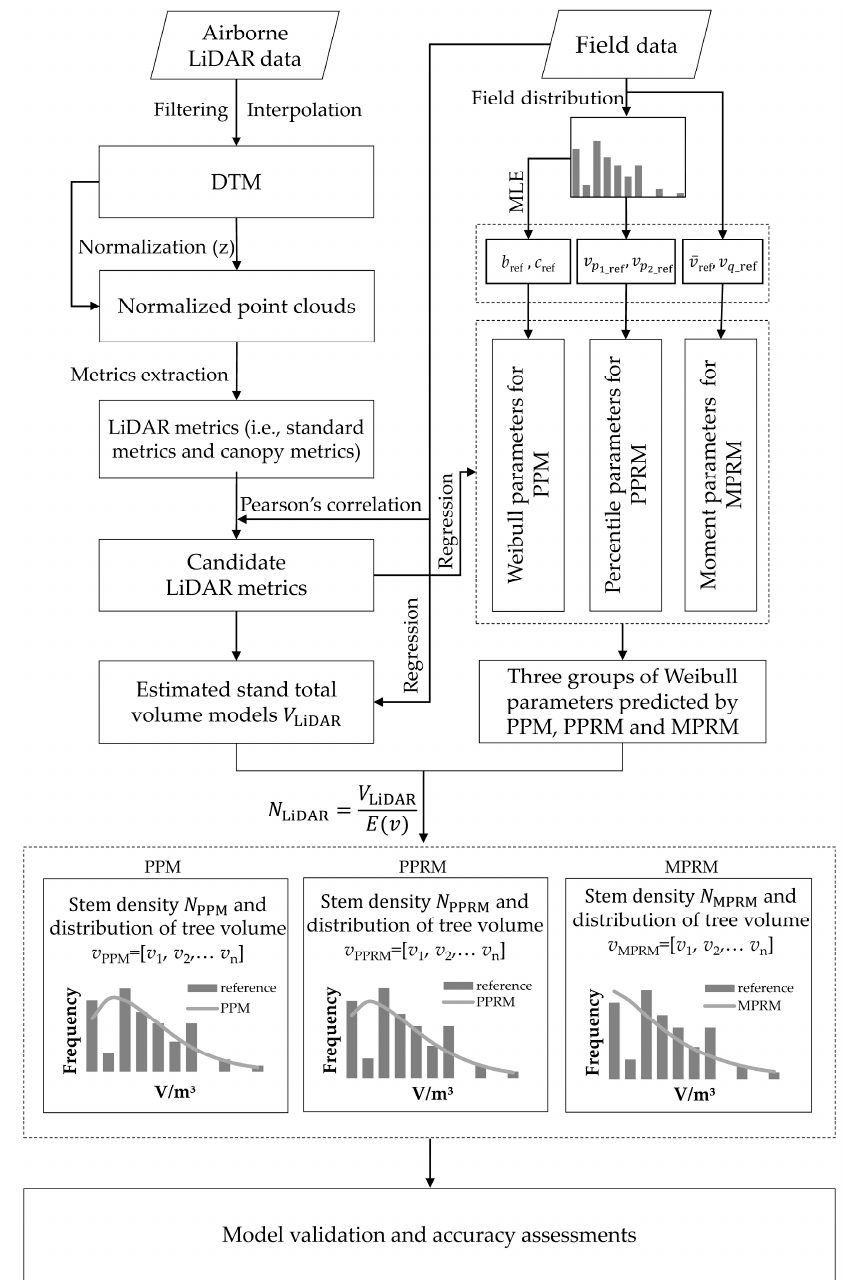
Figure 1. Overview of workflow for modelling individual volume distributions and predicting stem density. PPM: parameter prediction method; PPRM: percentile-based parameter recovery method; MRPM: moment-based parameter recovery method; DTM: digital terrain model. E ( v ) : mean volume predicted by LiDAR data; N LiDAR : stem density predicted by LiDAR data; V LiDAR : total volume predicted by LiDAR data; N PPM : LiDAR-predicted stem density based on the PPM; N PPRM : LiDAR-predicted stem density based on the PPRM; N MPRM : LiDAR-predicted stem density based on the MPRM; MLE: maximum likelihood estimation; b ref and c ref : scale and shape of the Weibull distribution, respectively; v p and v p : two percentiles of the field reference volume distribution within a plot; v q_ref : field reference mean volume within a plot; v ref : quadratic mean volume of the individual trees within a